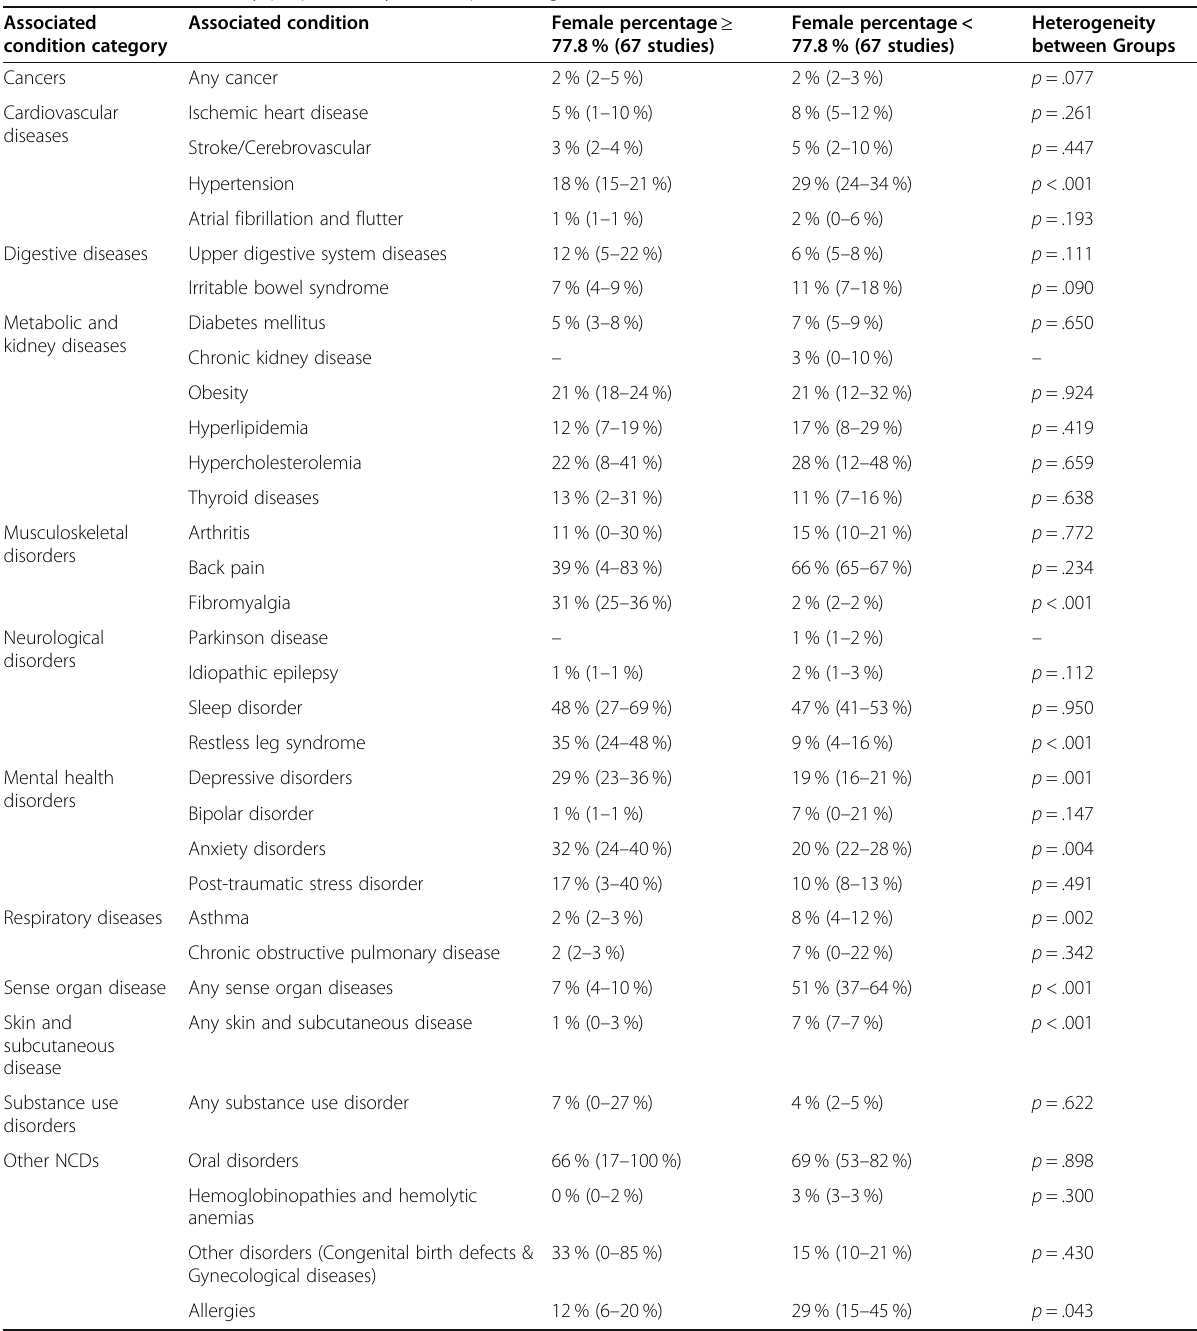
Table 4 Pooled comorbidity proportion by female percentage within studies Associated Associated condition category